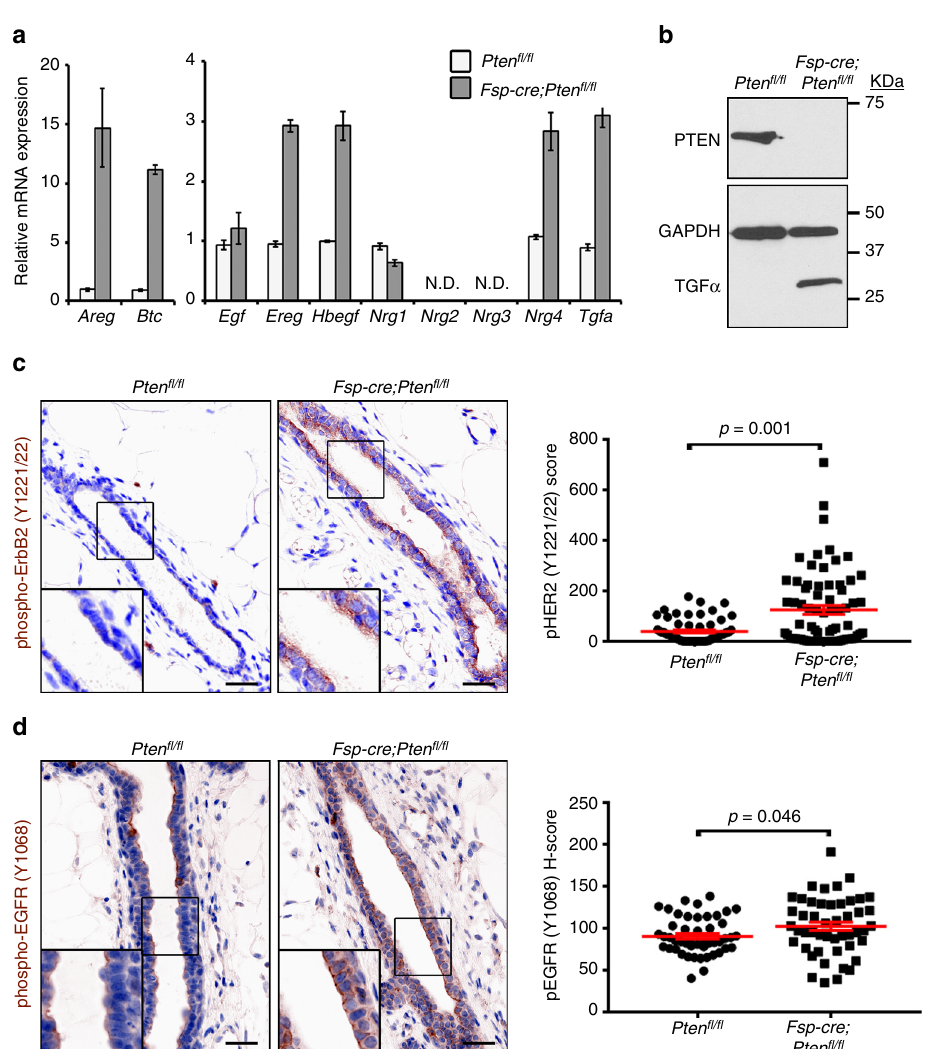
Fig. 3 Loss of stromal PTEN increases fi broblast EGF ligand expression and associated ErbB signaling activity in neighboring epithelium. a Areg , Btc , Egf , Ereg , Hbegf , Nrg1 , Nrg4 and Tgfa mRNA in immortalized control ( Pten fl / fl ) and PTEN-null ( Fsp-cre;Pten fl / fl ) MMFs. Bars represent mean expression of technical replicates relative to Gapdh ± s.e.m. Nrg2 and Nrg3 were not detectable (N.D.). b Western blot for PTEN, TGF- α and GAPDH in the immortalized control ( Pten fl / fl ) and PTEN-null ( Fsp-cre;Pten fl / fl ) MMFs. c Representative phospho-ErbB2 (Y1221/22) immunostaining and quanti fi cation (mean ± s.e.m.) of mammary epithelium in Pten fl / fl and Fsp-cre;Pten fl / fl mice. P value determined by two-tailed Mann – Whitney ( Pten fl / fl n = 61 fi elds/4 mice, Fsp-cre;Pten fl / fl n = 71 fi elds/4 mice). Scale bar = 20 μ m. d Representative phospho-EGFR (Y1068) immunostaining and quanti fi cation (mean ± s.e.m.) of mammary epithelium in Pten fl / fl and Fsp-cre;Pten fl / fl mice. P value determined by Welch ’ s t -test ( Pten fl / fl n = 48 fi elds/3 mice, Fsp-cre;Pten fl / fl n = 48 fi elds/3